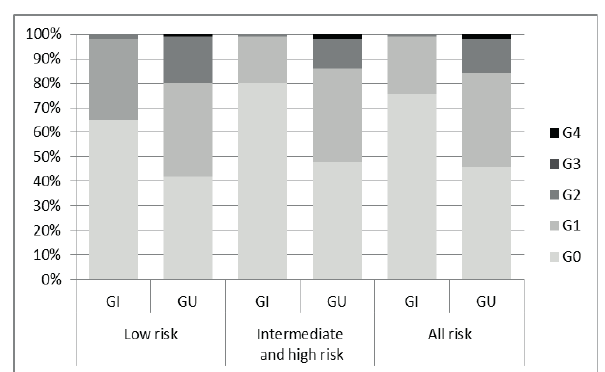
Fig. 1. early toxicity distribution.